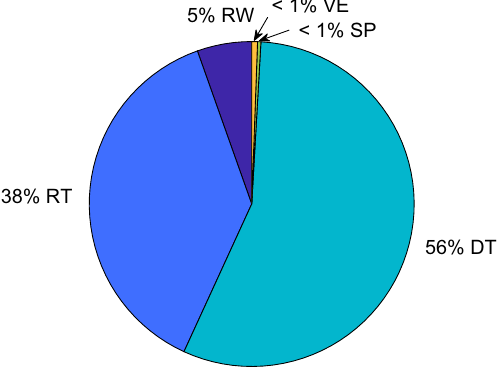
Figure 7. The average behavioral profile for a hiker, p hiker